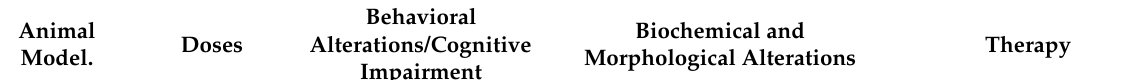
Table 3. Therapies used against Pb neurotoxicity in experimental